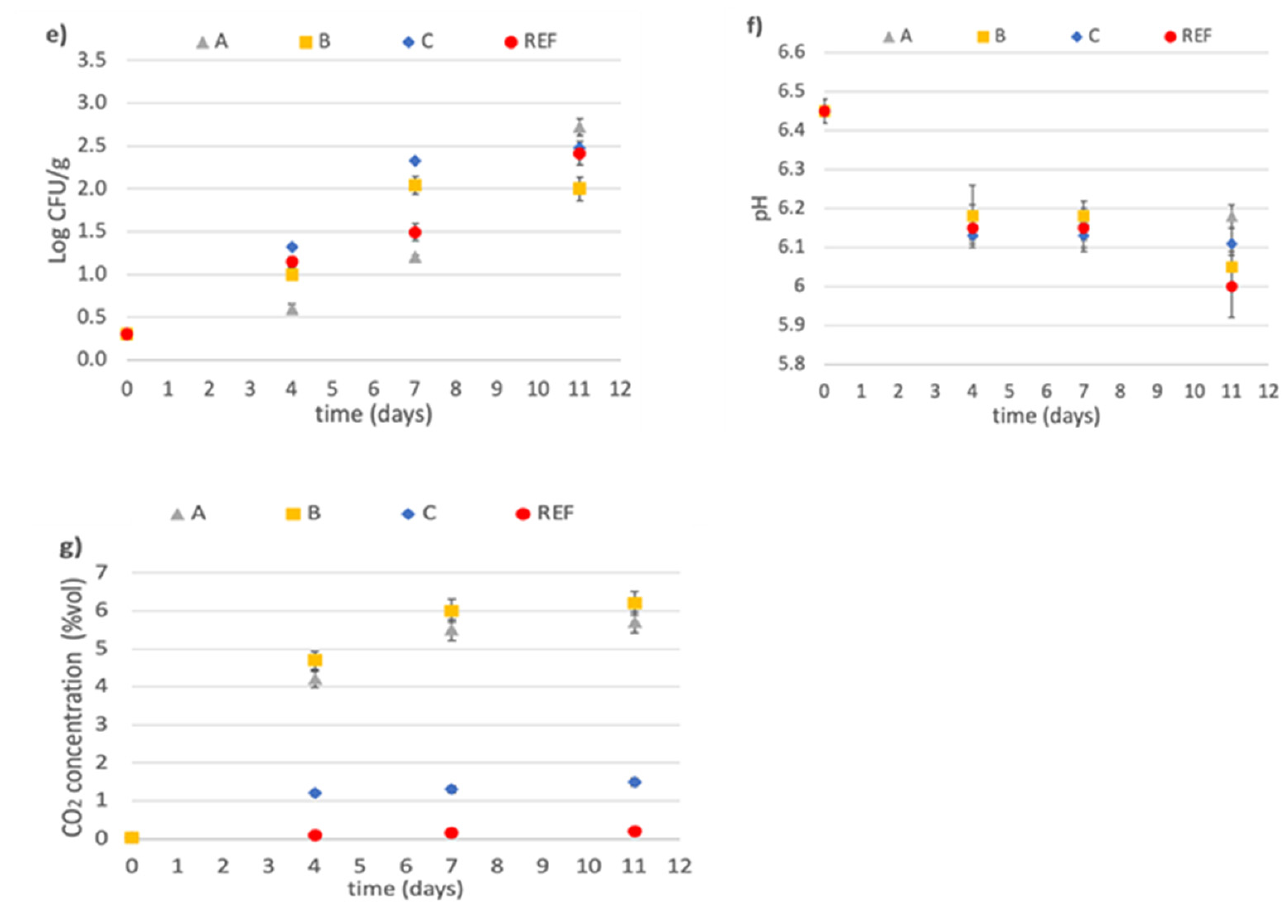
Figure 7. ( a ) Mass loss percentage, ( b ) water activity (a w ), ( c ) total microbial count, ( d ) lactic acid bacteria load, ( e ) yeasts and molds count, and ( f ) pH evaluated in fresh and packaged pumpkin samples, during shelf-life; ( g ) carbon dioxide concentration in headspace of pumpkin package in different films. REF: Polyethylene film; commercial biofilms: A, B and C .